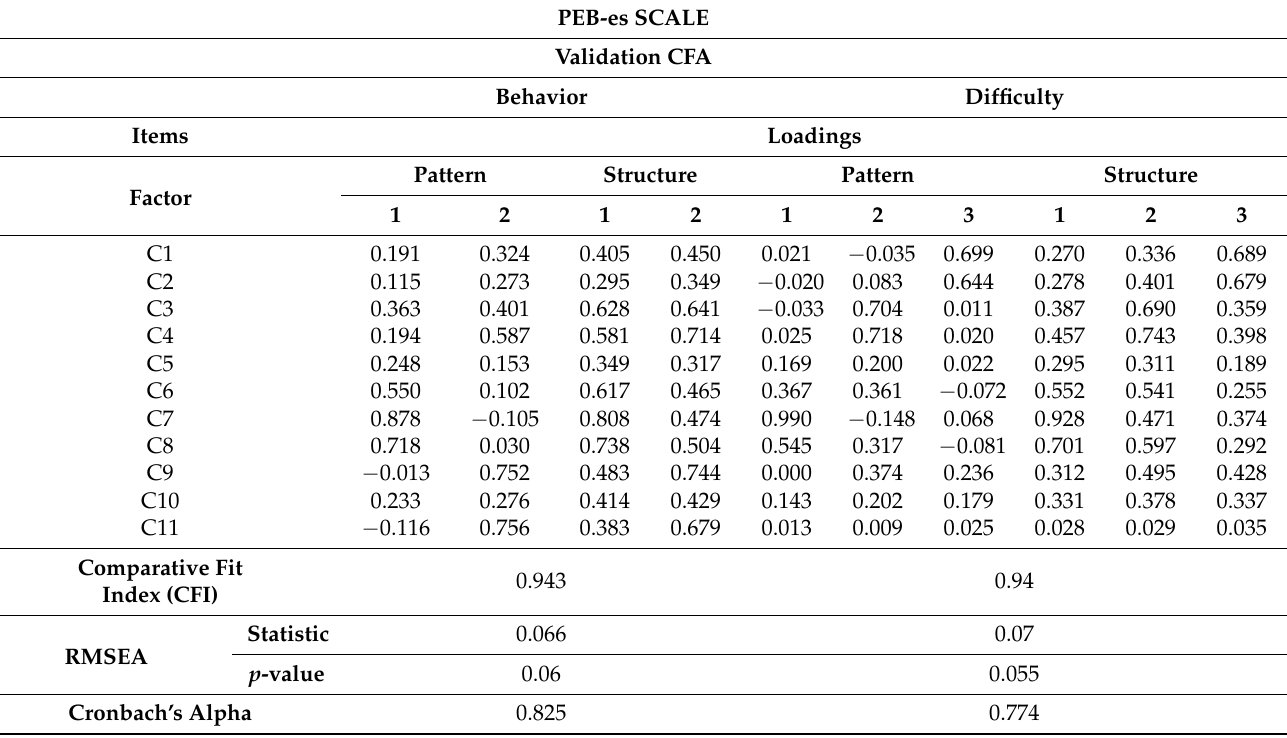
Table 7. Factor loadings and Cronbach’s alphas for the Personal Ecological Behaviors Scales (PEB-es) of the questionary NEAT-es 1st version CFA (n = 376